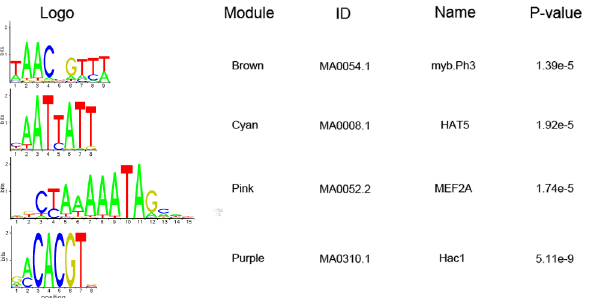
Fig 3. The motifs enriched in the LBPGs modules. The motifs enriched in 1-kb upstream sequences of the transcription start site of the LBPGs coexpressed module genes. (P-value was calculated by Ranksum